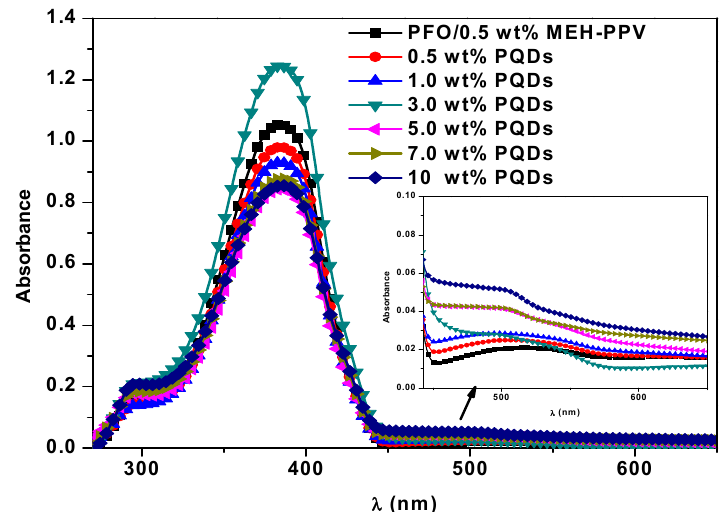
Figure 3. Absorption spectra of the hybrid thin films of PFO / MEH-PPV with various PQD